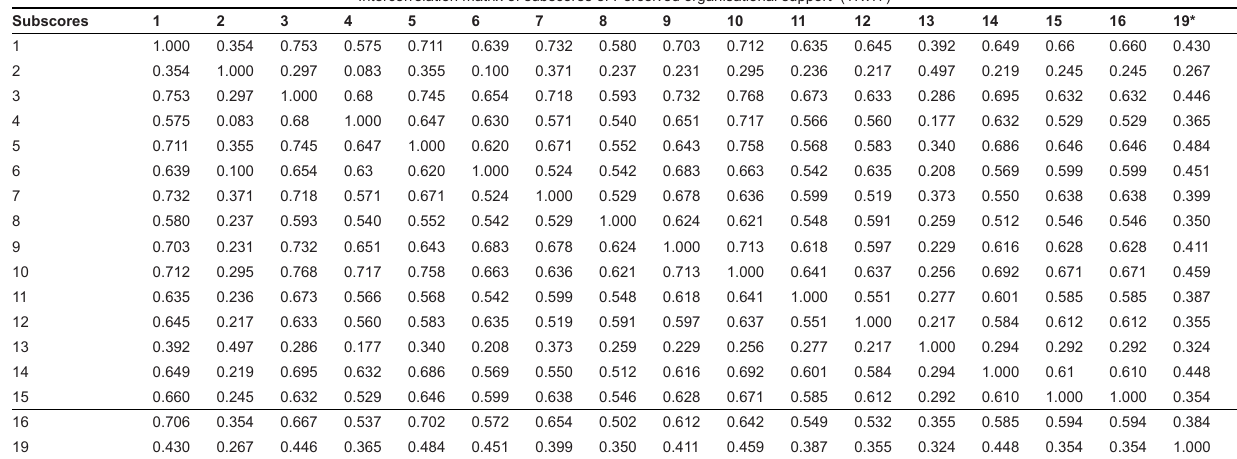
TABLE 2 Intercorrelation matrix of subscores of Perceived organisational support (17x17)